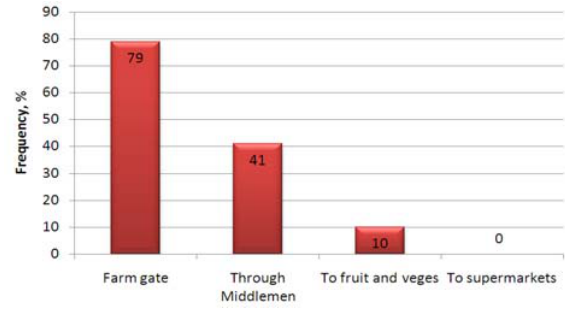
Fig. 6. Market channels used to sell farm